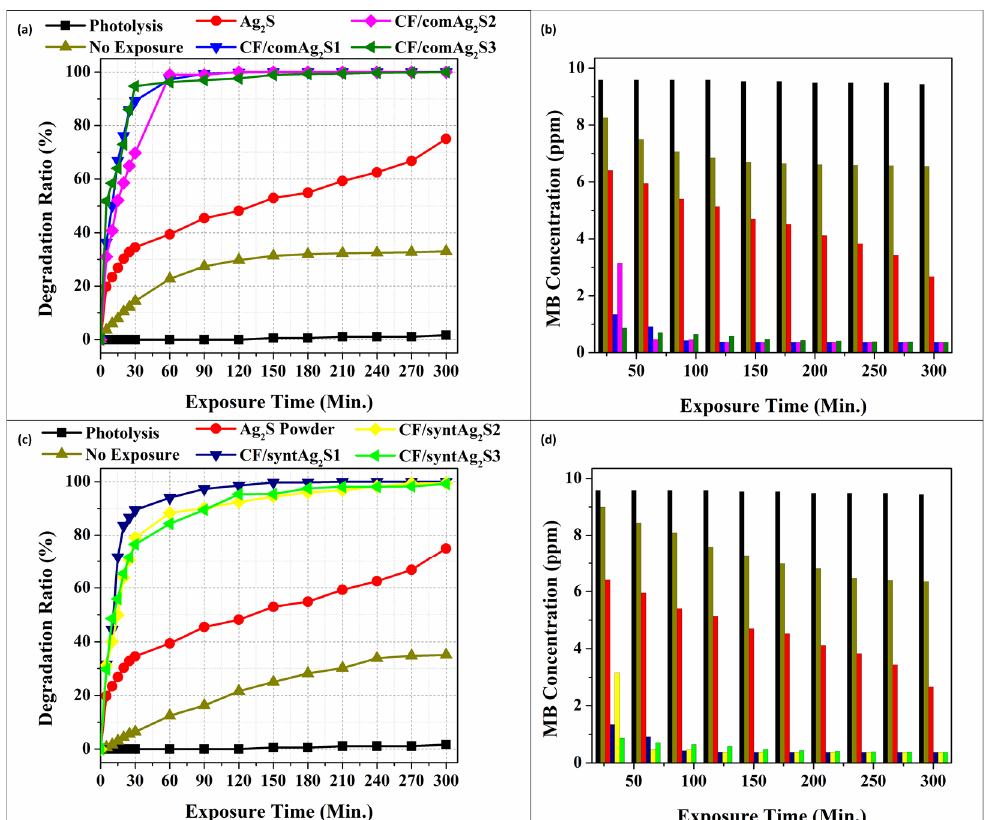
Figure 8 . ( a ) Degradation ratio of MB with Ag 2 S commercial as a catalyst; ( b ) The concentration of MB after photocatalytic activity using CF/comAg 2 S samples; ( c ) Degradation ratio of MB with synthesized Ag 2 S as a catalyst; ( d ) The concentration of MB after photocatalytic activity employing CF/syntAg 2 S samples.